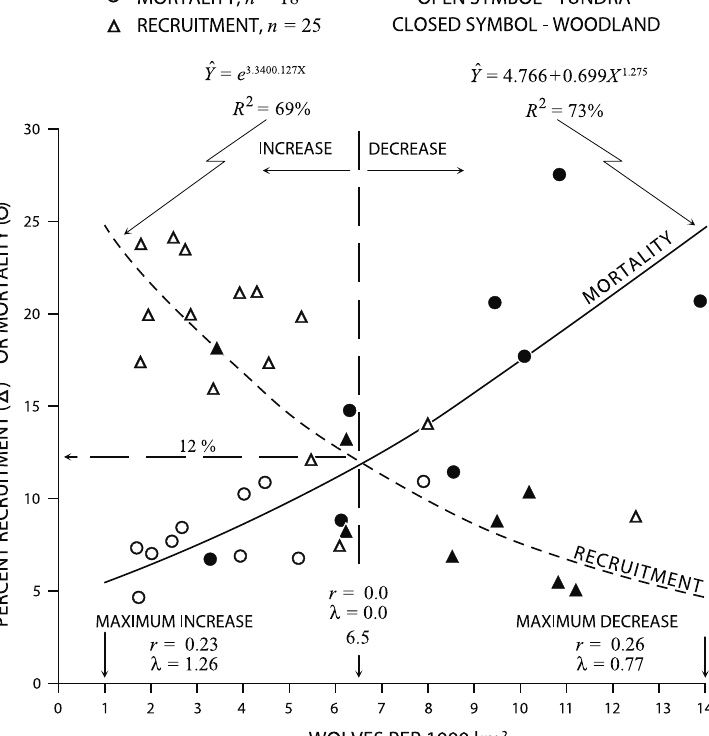
Fig. 1. The recruitment of caribou based mostly on the percentage of calves at 6 or 10-12 months-of-age, and adult mortality, both parameters regressed against the density of wolves. This figure is a modification of a figure in Bergerud & Elliott, 1986. The figure included all the studies in North America as of 1986 that had provided data on all three parameters, recruitment, adult mortality (mostly females) and wolf